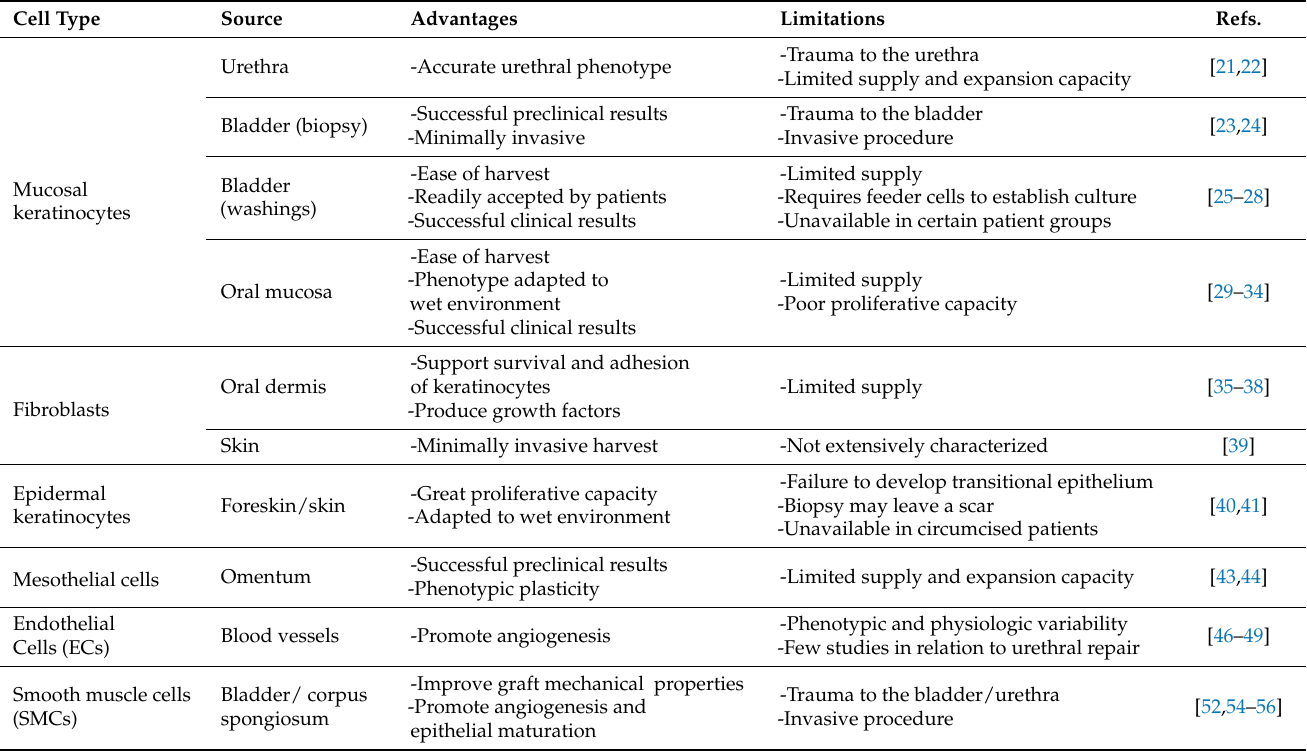
Table 1. Summary of main properties of differentiated cells used in urethral tissue